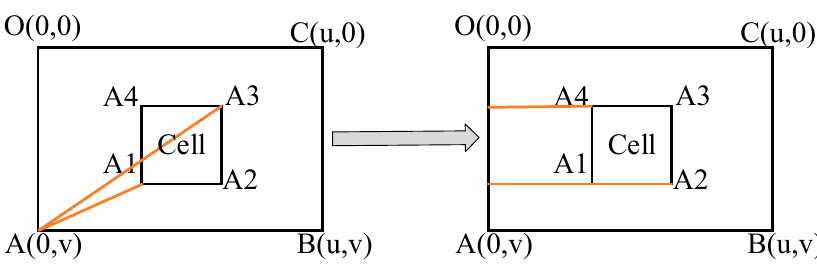
Figure 5. Recognition method of the cell vertex in the horizontal channel.